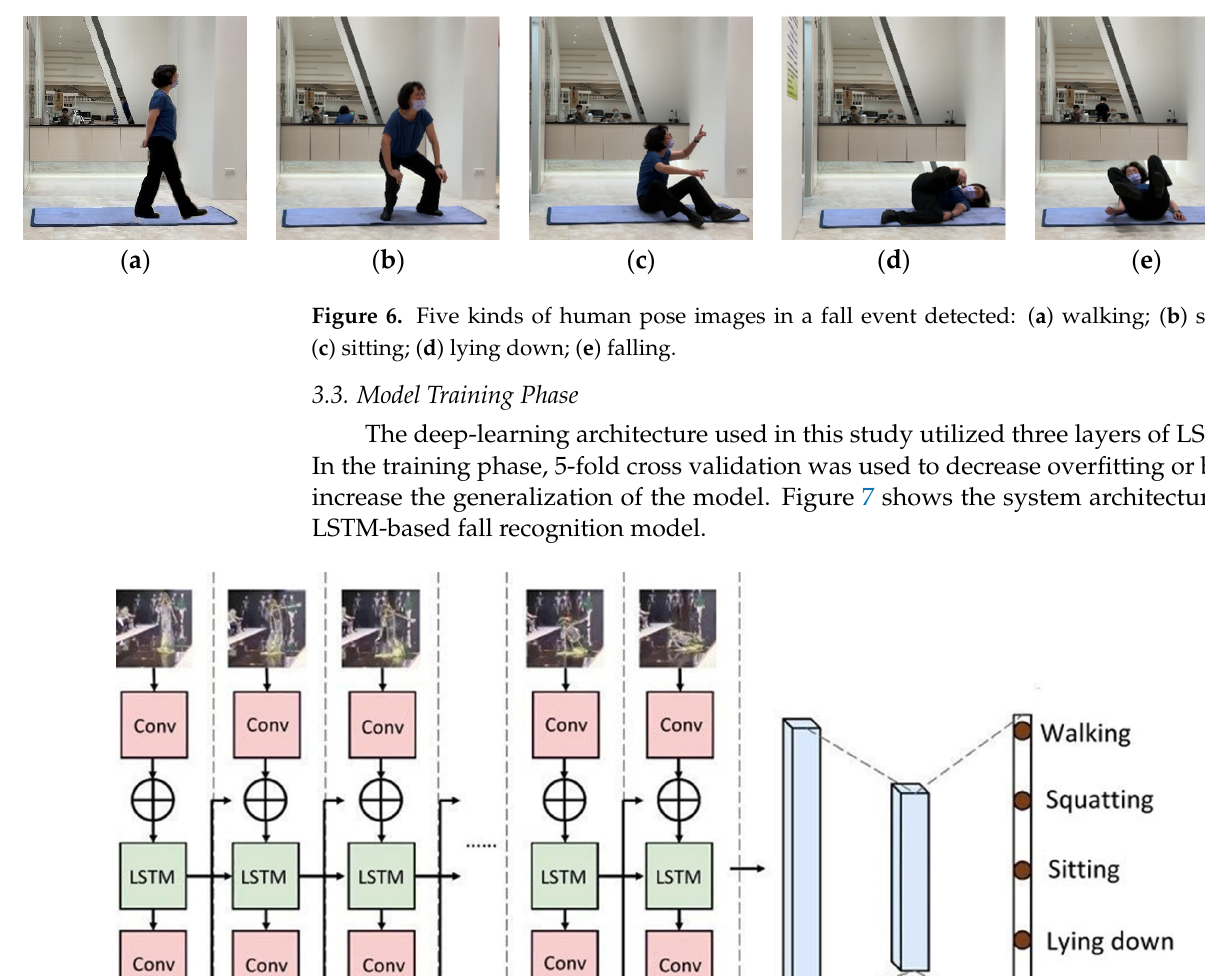
6 of 19 Figure 5. Flowchart of the human pose image recognition system.